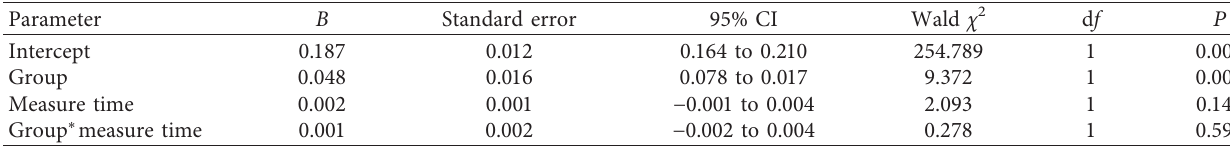
Table 4: GEE model parameter estimates of prealbumin.